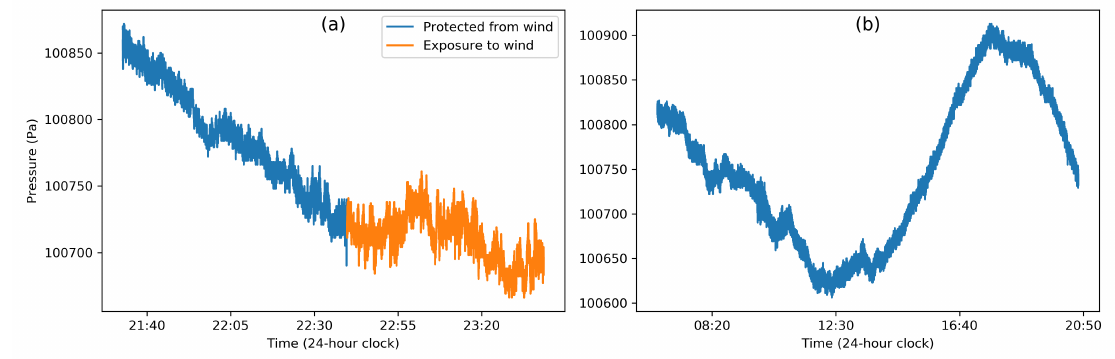
Figure 2. An illustration of the effects of climate and weather on barometric pressure: ( a ) effect of wind and ( b ) diurnal pressure cycle in Singapore. Recorded by a custom-made device (barometer model: BMP280) with ∼ 1 Hz sampling